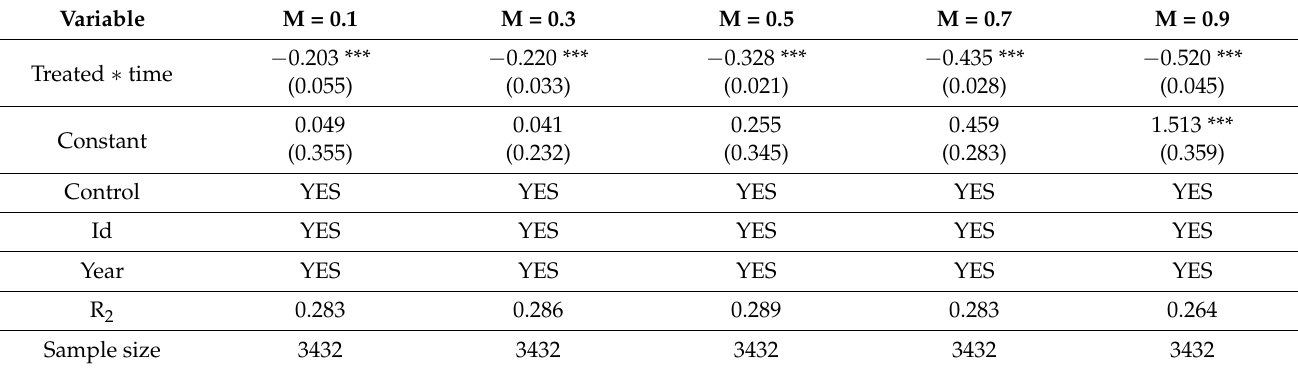
Table 6. Quantile